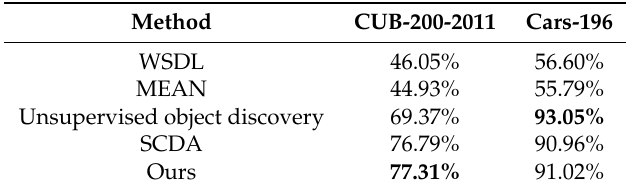
Table 2. Accuracy of weakly supervised